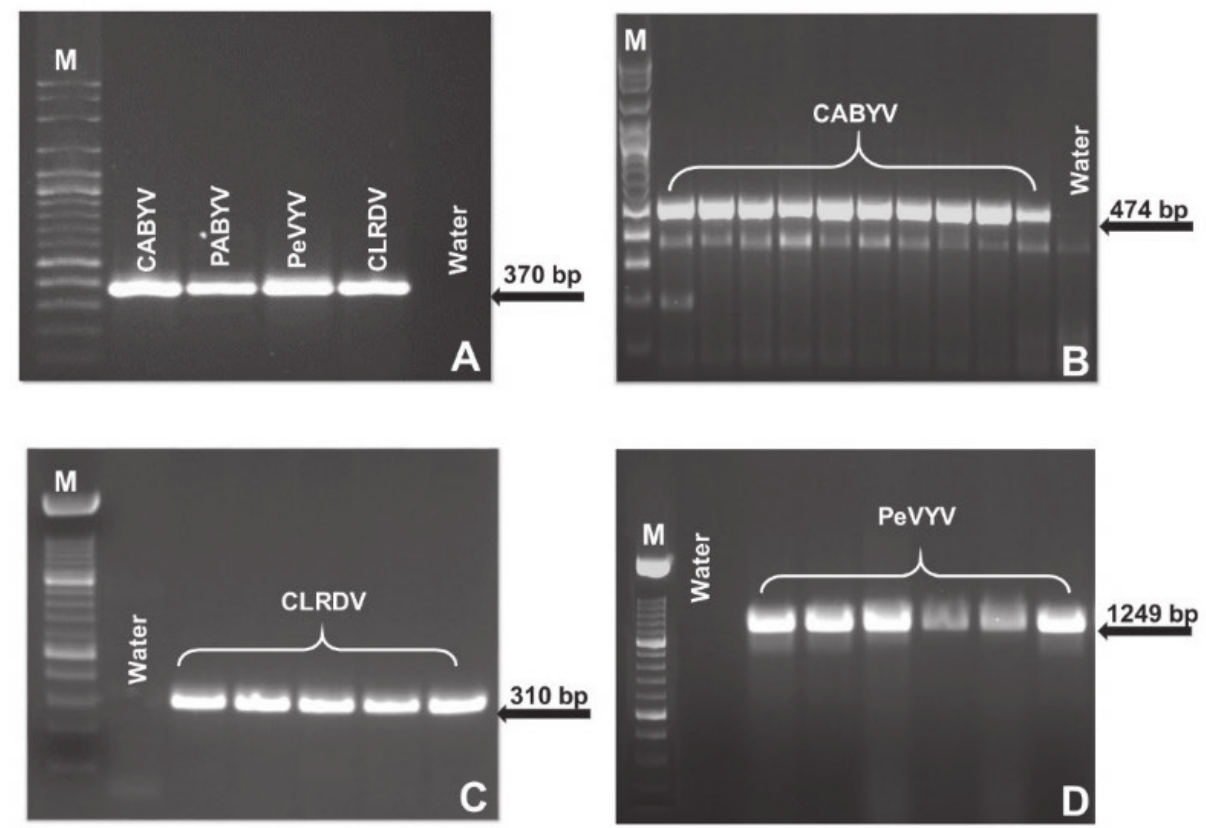
Figure 2. (A) Detection of Cucurbit aphid‐borne yellows virus (CABYV), Pepo aphid-borne yellows virus (PABYV), Pepper vein yellows virus (PeVYV) and Cotton leafroll dwarf virus (CLDRV) by RT-PCR using AS3/Pol3870F generic primers; (B) Detection of CABYV by MP-PCR using AS3/CABYV3635F specific primers; (C) Detection of CLRDV by RT-PCR using Pol3982R/CLRDV3675F specific primers (one sample from Sudan and four samples from Uzbekistan were used as positive controls); (D) Detection of PeVYV by RT-PCR using PeF/ PeR specific primers. M = DNA Ladder VC 100 bp Plus (Cat No. NL1405, vivantis,